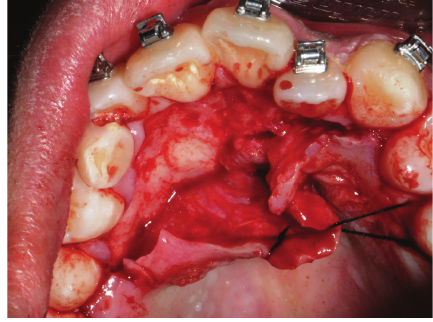
Figure 4: Mucoperiosteal flap reflection and bone removal.